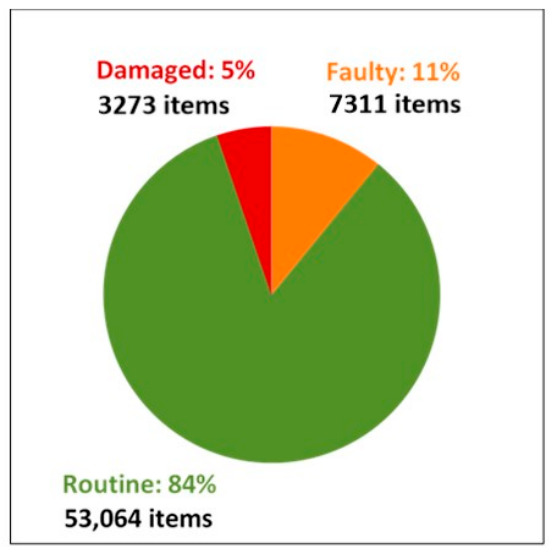
Figure 4. Percentage of items fixed under the NSW Housing for Health Program ( n = 63,648) by the reason for repair from 1998–2017.